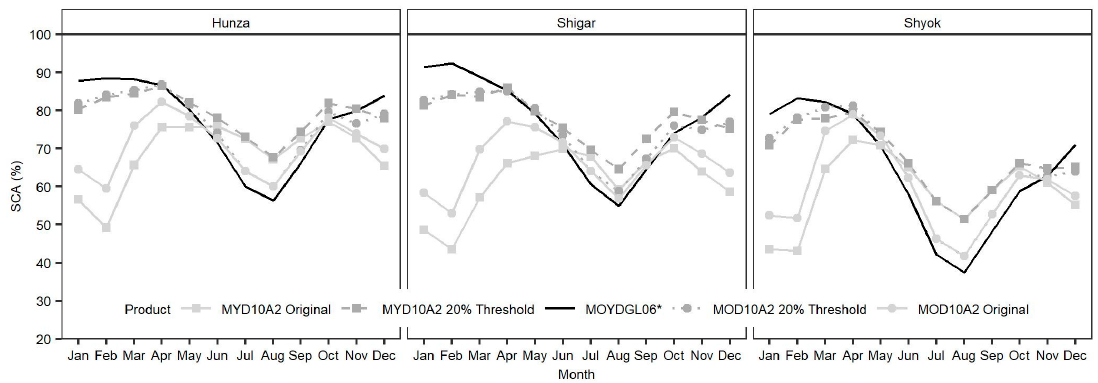
Figure 4. Monthly mean SCAs in the Hunza, Shigar, and Shyok basins.